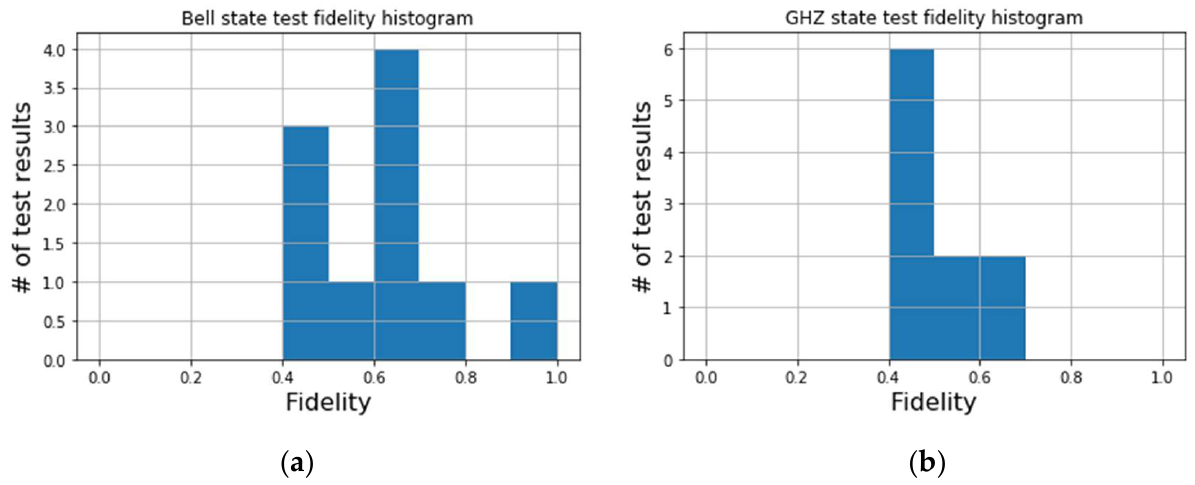
Figure 5. Histograms of maximum fidelity over 100 test steps for 10 independent samples. ( a ) The 2-qubit Bell state experiment. ( b ) The 3-qubit GHZ state experiment.